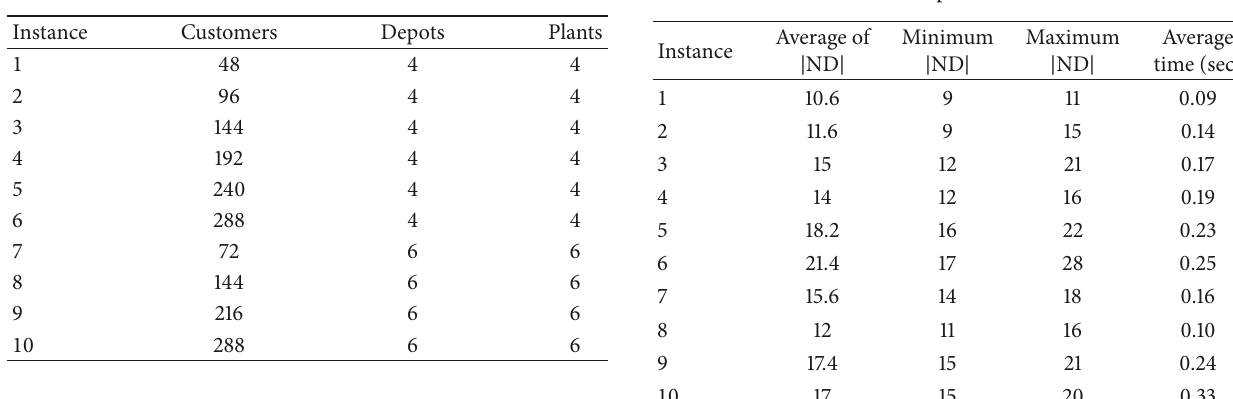
Table 1: Instances’ sizes. Table 2: Computational